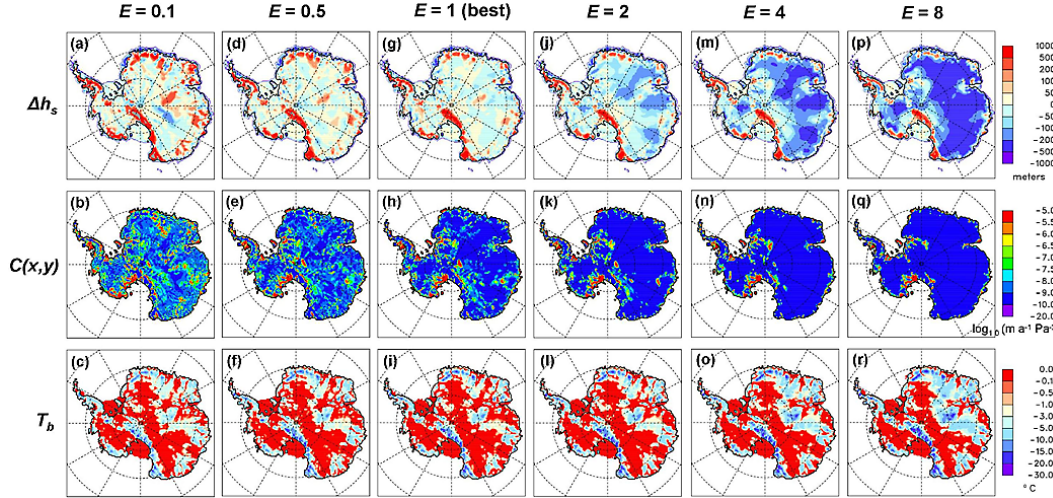
Fig. B1. Crude bounding of enhancement factor for internal flow ( E) . Top row: model minus observed surface ice elevation, meters. Middle row: basal sliding coefficients C(x,y) , log 10 (ma − 1 Pa − 2 ) . Bottom row: homologous basal temperatures T b , ◦ C. Each column shows results using basic inverse method (no sub-grid topographic influence) for a different value of the internal-flow enhancement factor E , ranging from E = 0 . 1 to E =